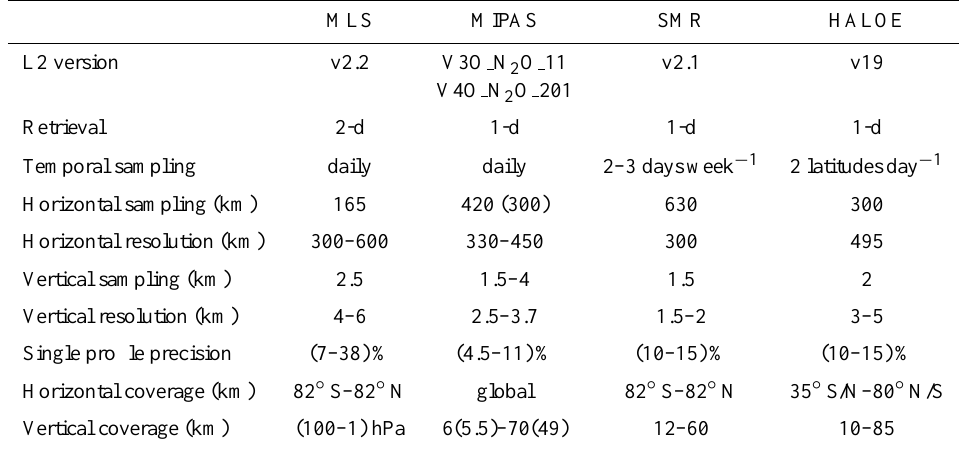
Table 1. Basic information of the relevant sampling characteristics (nominal values) of the MLS, MIPAS, SMR, and HALOE instruments (see also the